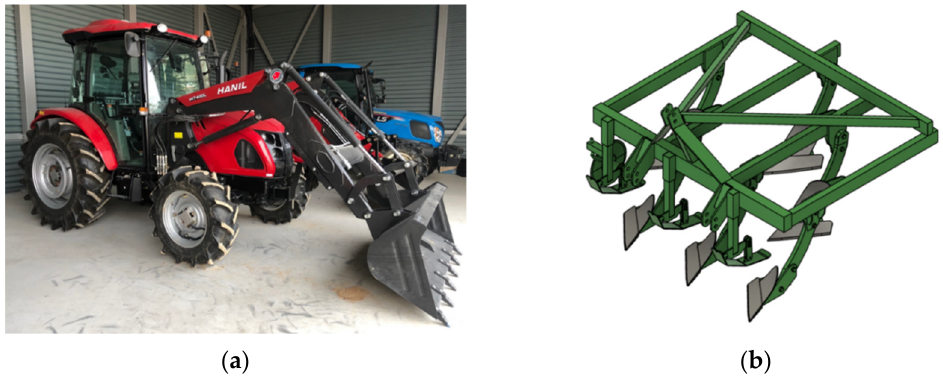
Figure 1. Tractor-implement system: ( a ) 42 kW class agricultural tractor (TX58, TYM); ( b ) 6-rows moldboard plow (WJSP-6S, Woongjin). Table 2. Specification of the tillage implement.